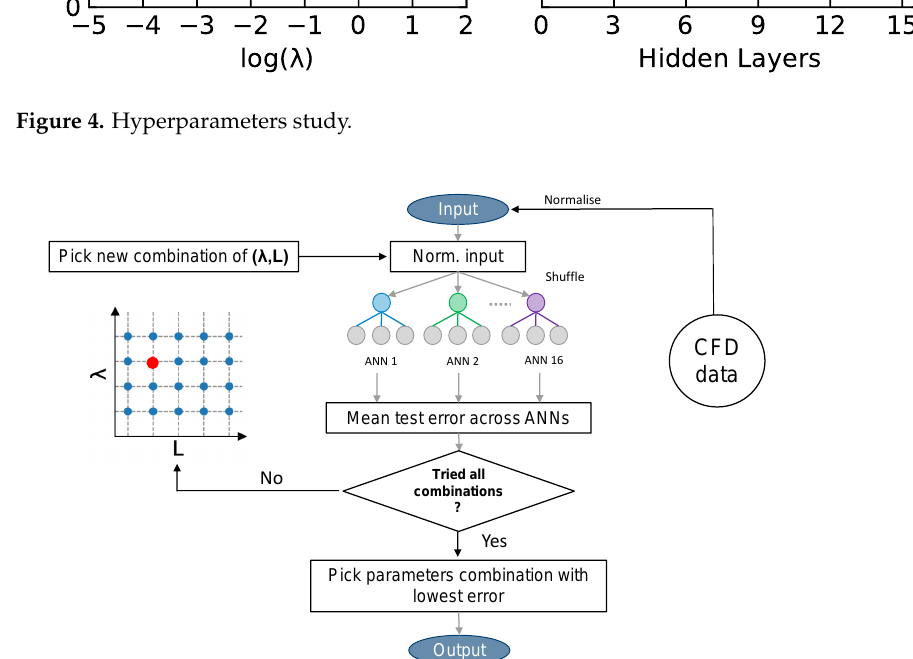
Figure 5. Flowchart for hyperparameters